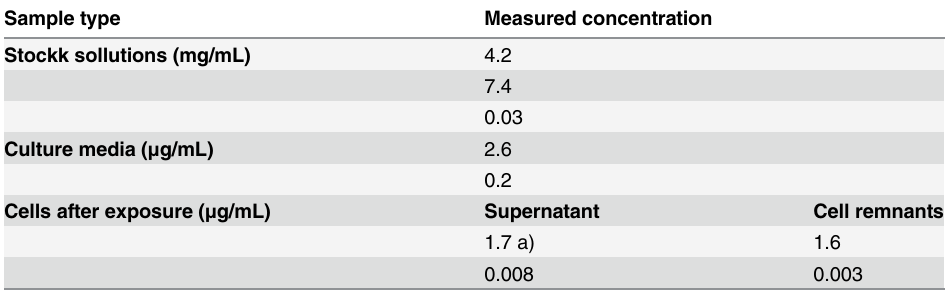
Table 3. PBDE measurements in stock solution, culture media and cells, mean of double